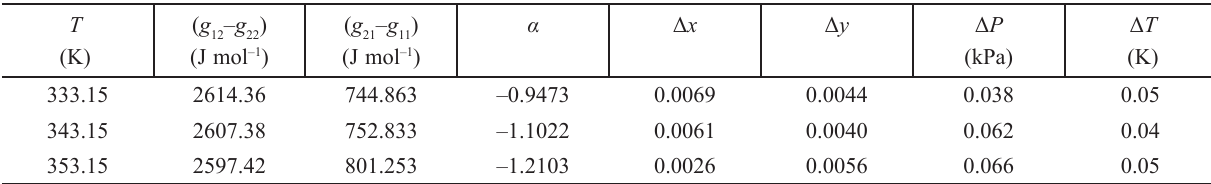
Table 4 – NRTL parameters and average absolute deviations Δ for the 2-methylpropan-2-ol + water (2) system